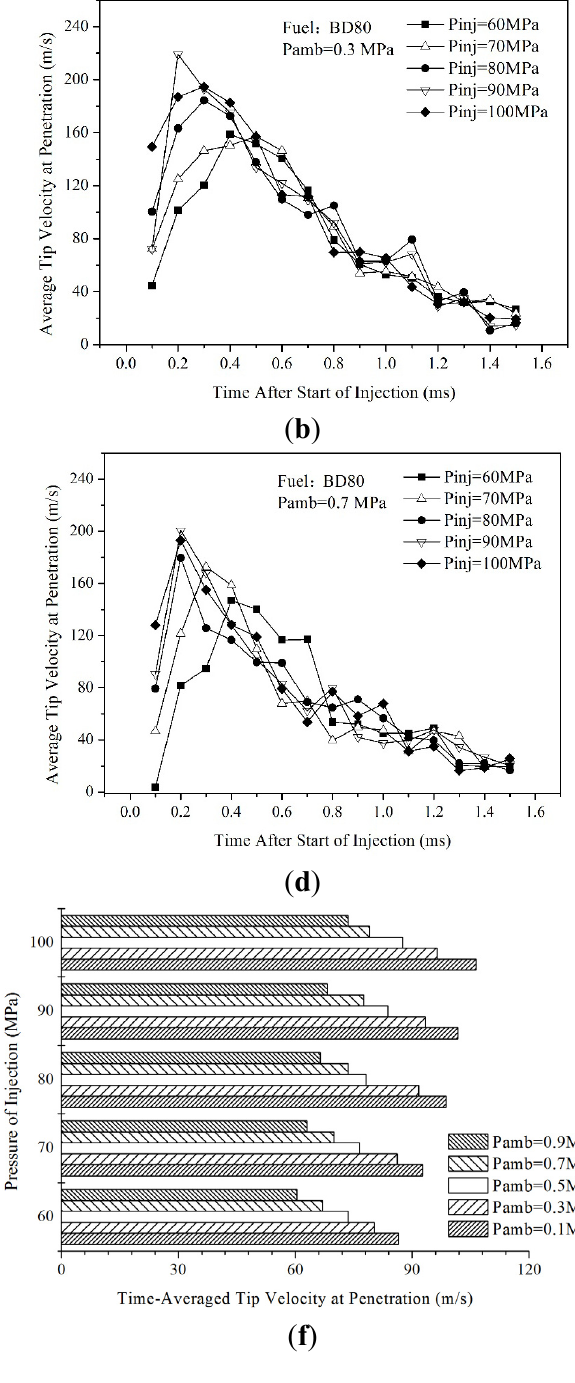
Figure 4. The average tip velocity under different ambient pressures (BD80): ( a ) Pamb = 0.1 MPa; ( b ) Pamb = 0.3 MPa; ( c ) Pamb = 0.5 MPa; ( d ) Pamb = 0.7 MPa; ( e ) Pamb = 0.9 MPa; ( f ) the time-averaged tip velocity at penetration under different injection pressures and ambient